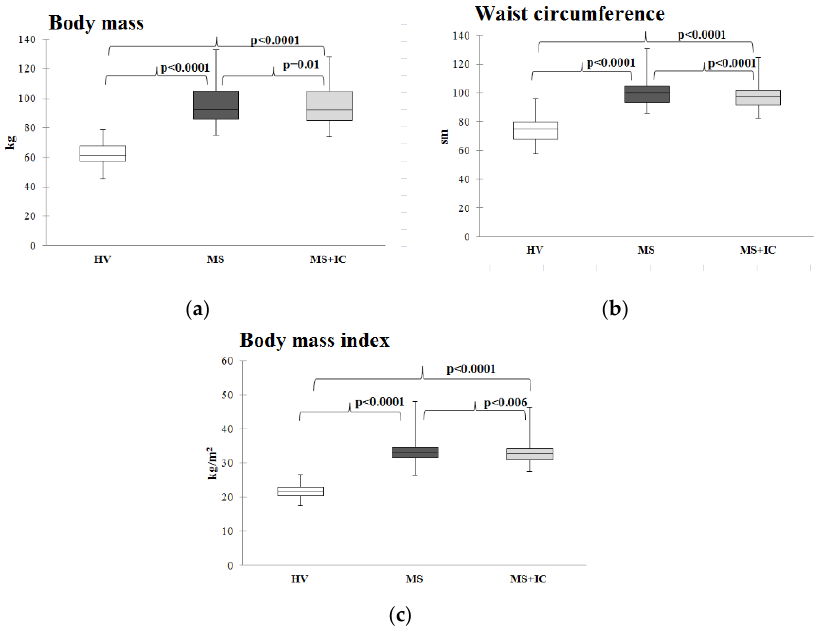
Figure 4. Body mass ( a ), waist circumference ( b ), and body mass index ( c ) of patients with MS before and after therapy. Notes: HV—healthy volunteers; MS—patients with metabolic syndrome; MS+IC—patients with metabolic syndrome after consumption of indigenous consortium. Results are presented as median (25%; 75%).